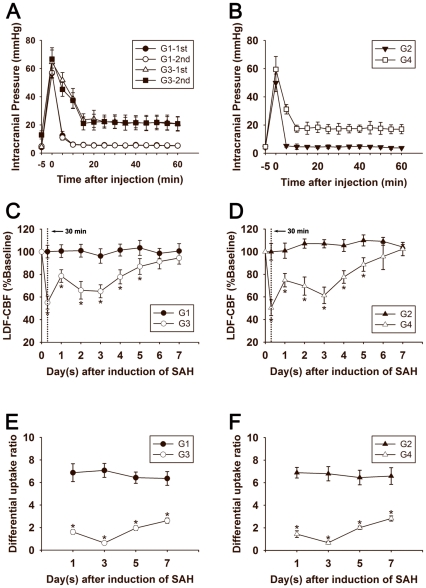
Line graphs (A and B) show the changes of ICP within 60 minutes following operation in G1, G2, G3 and G4 groups.Data are means±SD, n = 5 in each group. G1 group: cisterna magna saline injection. G2 group: prechiasmatic cistern saline injection. G3 group: cisterna magna blood injection. G4 group: prechiasmatic cistern blood injection. ICP: intracranial pressure, SAH: subarachnoid hemorrhage. Line graphs (C and D) show the surface CBF changes following 7 days after operation. Data are means±SD, n = 8 in each group. *, p<0.05, G1 vs. G3, G2 vs. G4. CBF: cerebral blood flow. Line graphs (E and F) show the regional CBF (DUR) changes using isotope [125I]-IMP following 1, 3, 5, and 7 days after operation. Data are means±SD, n = 5 in each group. *, p<0.05, G1 vs G3, G2 vs G4. DUR: differential uptake ratio, [125I]-IMP: [125I]N-isopropyl-p-iodoamphetamine.